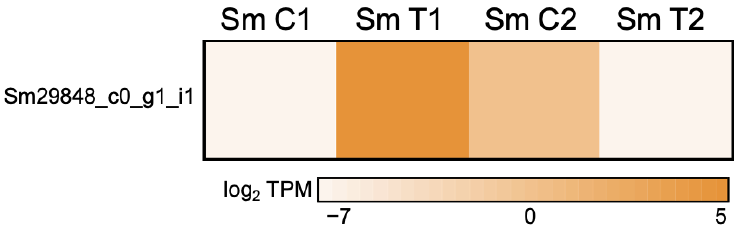
Figure 9. Heat map revealing relative gene expression of SmBub2 (mitotic checkpoint protein in appressorium formation) in S. mycoparasitica interacting with Fusarium graminearum 3-ADON. Sm C1 and Sm C2 represent S. mycoparasitica incubated for 1.5 and 3.5 days, respectively, without interaction with the host, whereas Sm T1 and Sm T2 represent S. mycoparasitica interacting with the host for respective incubation times (1.5 and 3.5 days). Colors indicate the range of the transcripts per million (TPM) expressed as log 2 TPM values for comparisons of relative gene expression to depict the overexpressed SmBub2 on SmT1.